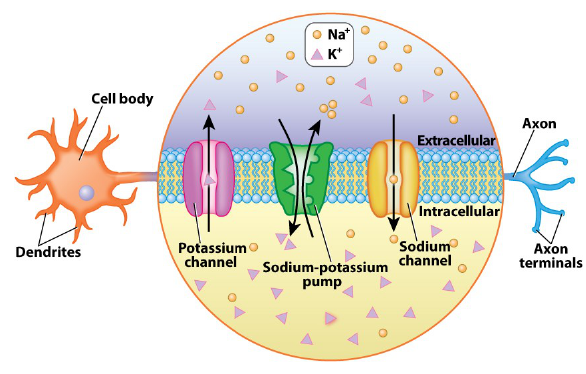
Figure 11: A typical biological